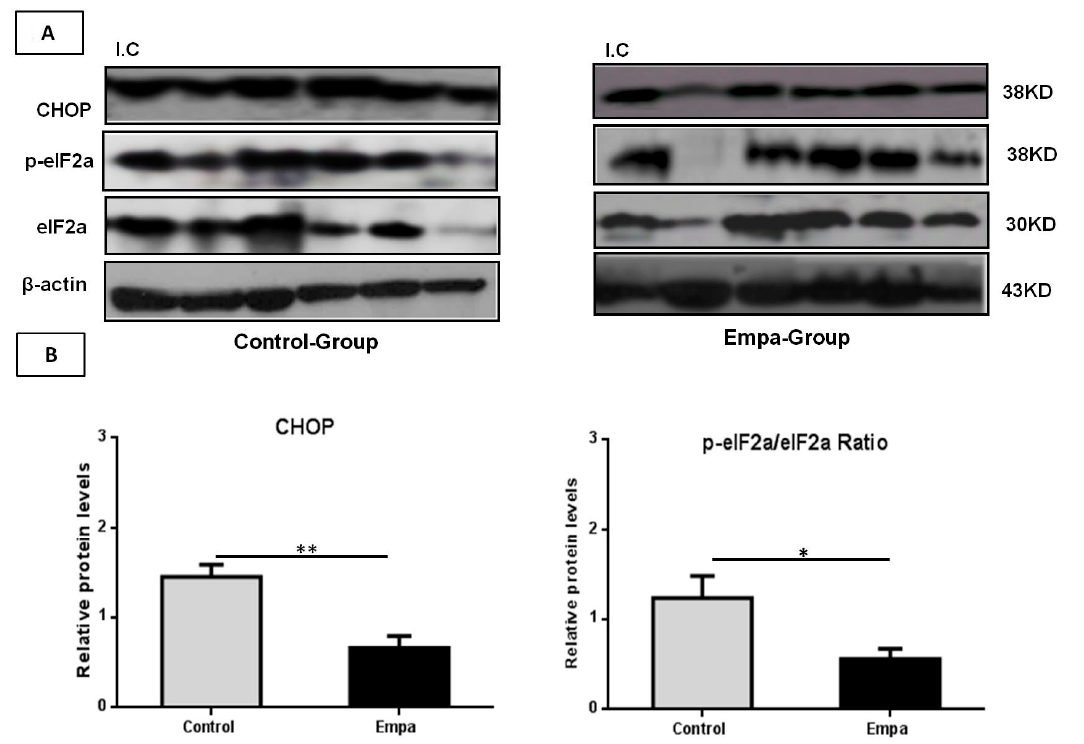
Figure 5. Empagliflozin administration for five weeks reduces protein levels of ER stress markers. ( A ). Western blot analysis of CHOP, total elf-2 α and phospho elf-2 α in liver tissues. ( B ) Quantitative analyses showed that empagliflozin reduces the protein levels of CHOP, p-elf-2 α /elf-2 α ratio. Data are expressed as the mean ± SEM (*: p < 0.05; **: p < 0.01; I.C: Internal control).